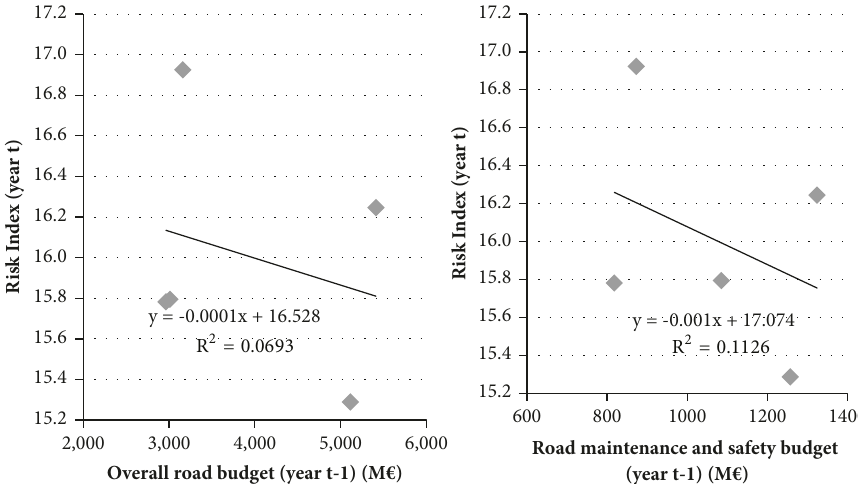
Figure 3: Relationship between Risk Index (year t) and Road Budgets (year t-1).